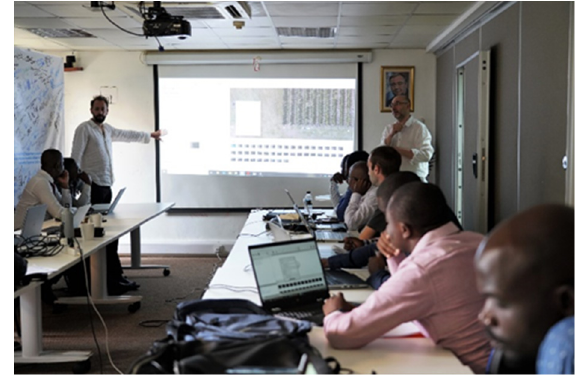
Figure 7. Meeting with representatives of the local institutions, UNICEF, DODMA, COPI, and the partner